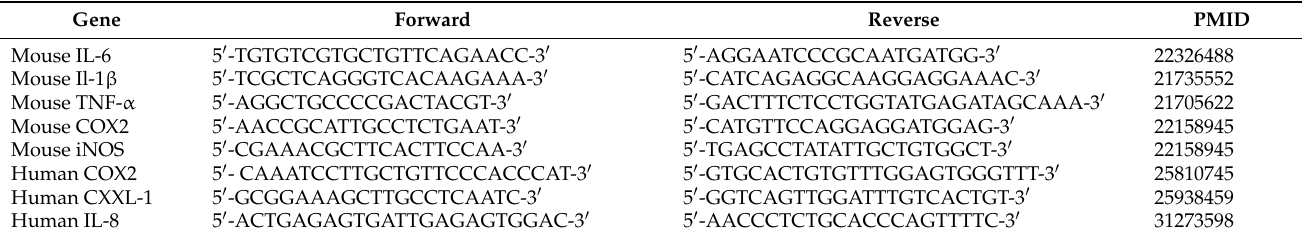
Table 1. Primer sequence used for real-time